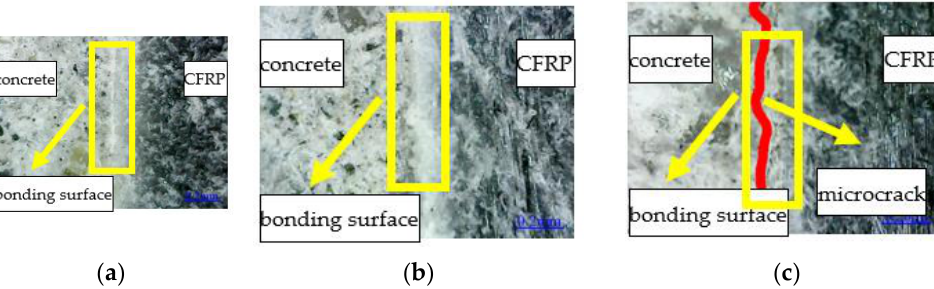
Figure 20. Microstructure of bonding surface between CFRP and concrete: ( a ) RFND; ( b ) RFSI-400; and ( c ) RFSF-100.